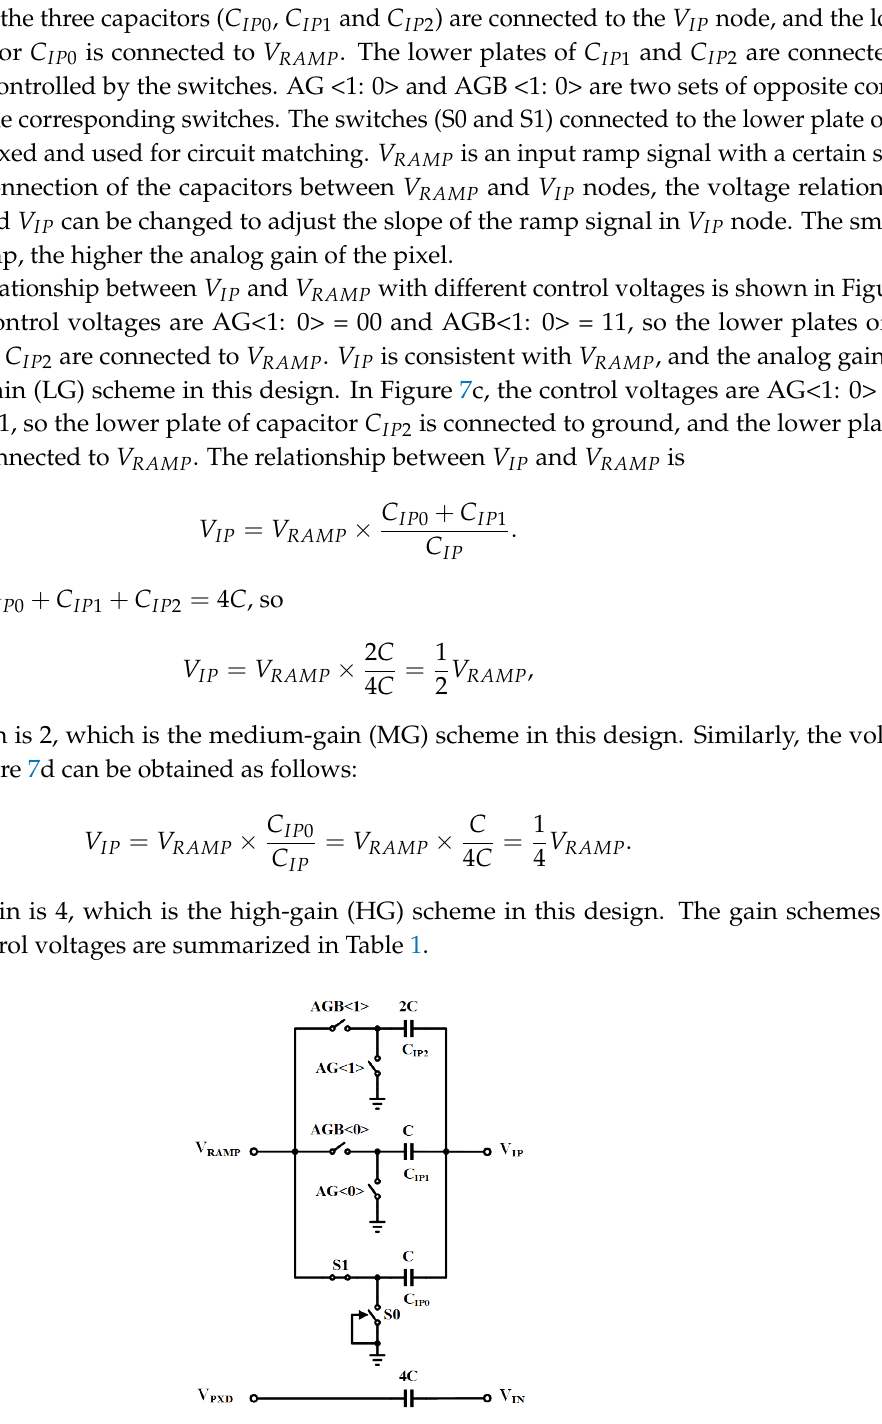
Figure 6. Switched-capacitor based gain control